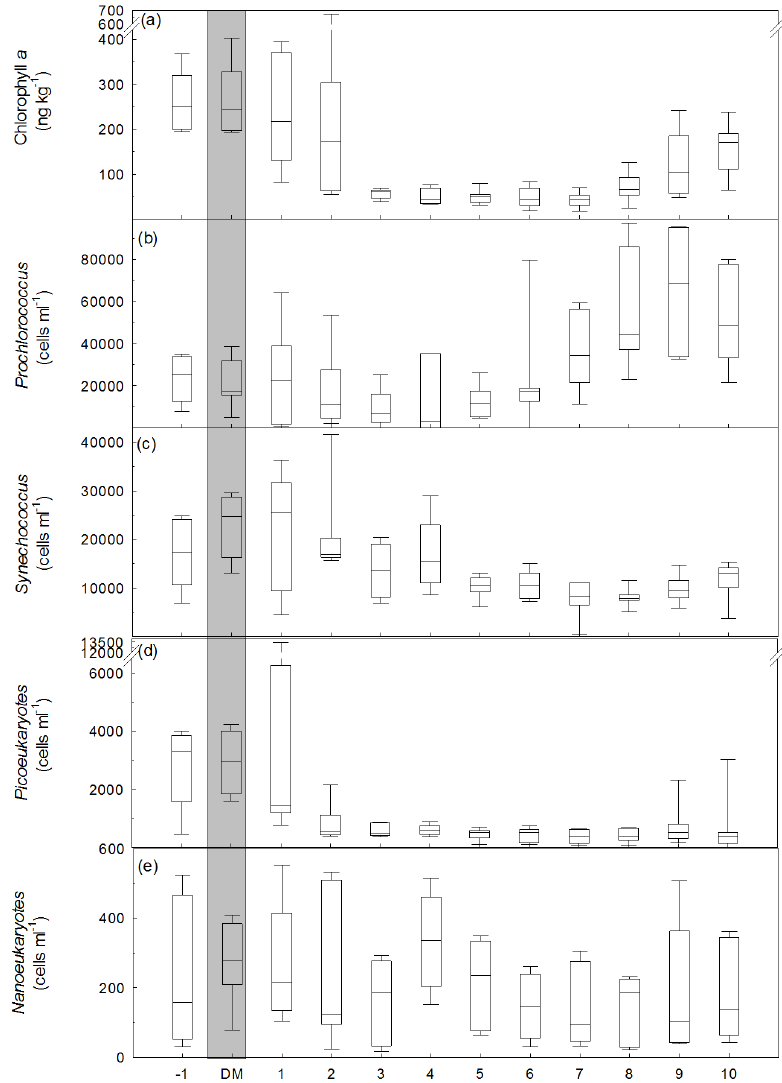
Figure 9. Box–whisker plot comparing the annual variation in chlorophyll a and cell counts for Prochlorococcus , Synechococcus , pi- coeukaryotes, and nanoeukaryotes relative to the deep mixing at a depth of 0–25m at BATS (data used are from January 2005 to De- cember 2011). The gray bar represents the period of deep mixing for each year. All else as in Fig.